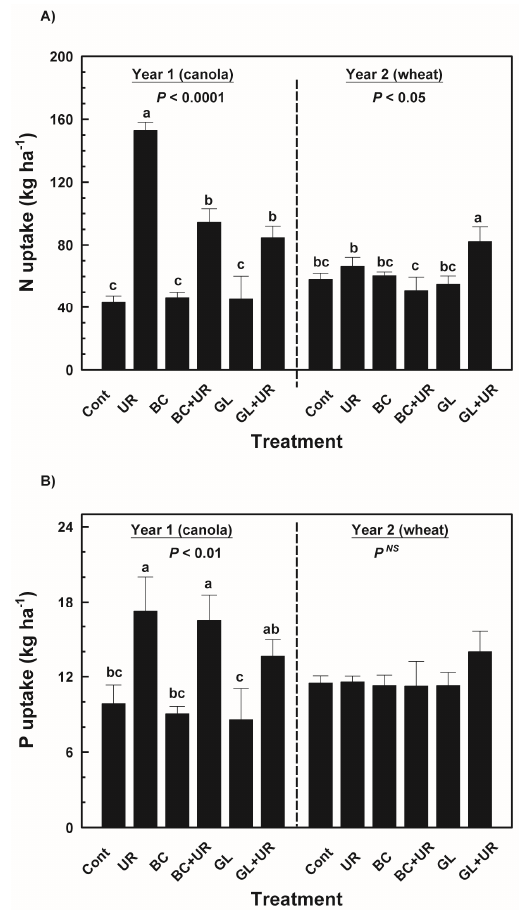
Figure 2. Total plant N uptake ( A ) and total plant P uptake ( B ) responses to treatment application during a 3-year field study in Central Butte, SK. Treatments were applied once in spring 2009 and were control (Cont), urea (UR), biochar (BC), biochar plus N (BC + UR), glycerol (GL) and glycerol plus N (GL + UR). For a year, bars sharing the same letter among treatments are not significantly different according to LSD test ( p ≤ 0.1). Errors bars represent standard error of mean ( n = 4). NS denotes not significant at p ď